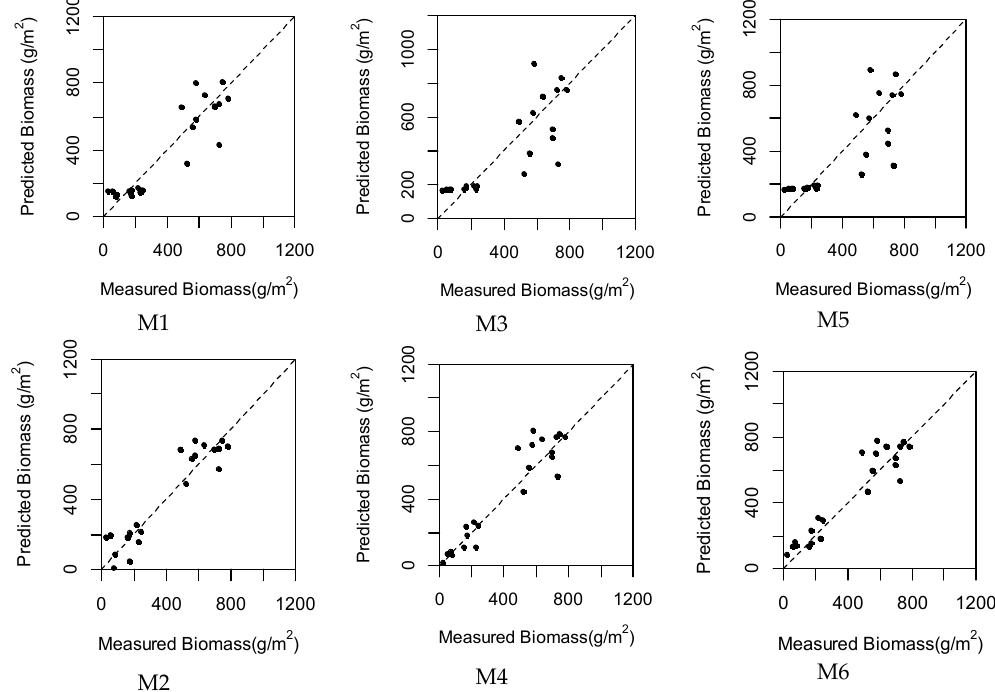
Figure 10. The scatter plots of measured and predicted aboveground biomass of six different aboveground biomass estimation models using independent validation data. M1: the linear regression constructed by CHM_max; M2: the logarithmic regression constructed by CHM_max; M3: the linear regression constructed by CHM_mean; M4: the logarithmic regression constructed by CHM_mean; M5: the linear regression constructed by CHM_median; M6: the logarithmic regression constructed by CHM_median.